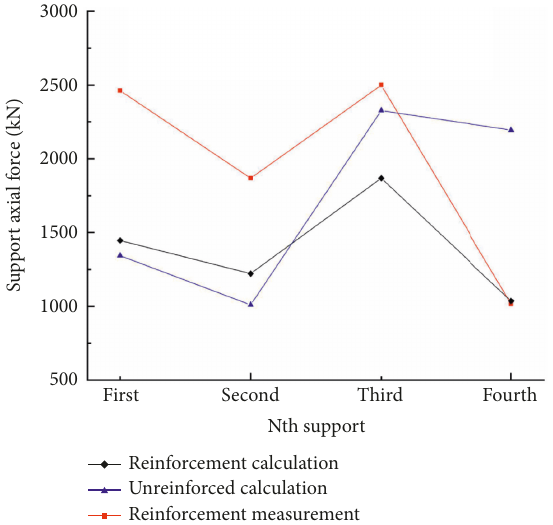
Figure 6: Axial forces of the inner